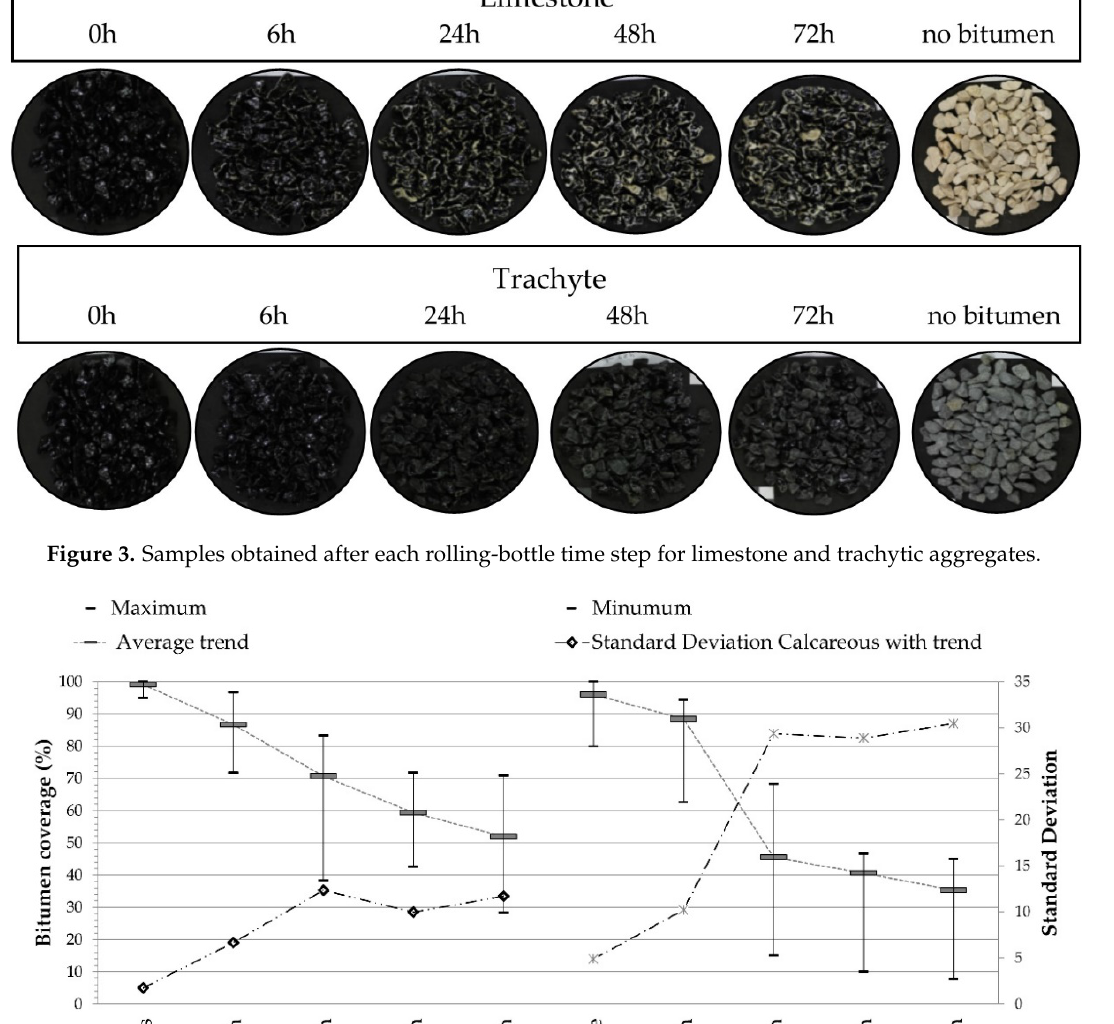
Figure 3. Samples obtained after each rolling-bottle time step for limestone and trachytic aggregates.